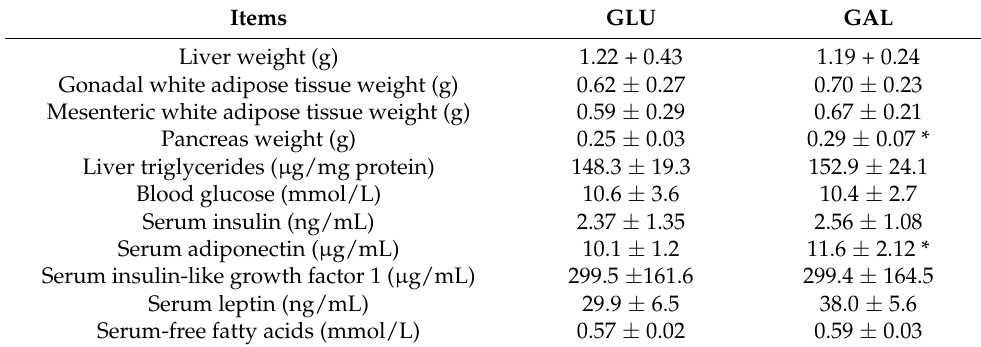
Table 1. Organ weights and serum parameters in GLU and GAL mice at the end of the study 1 .